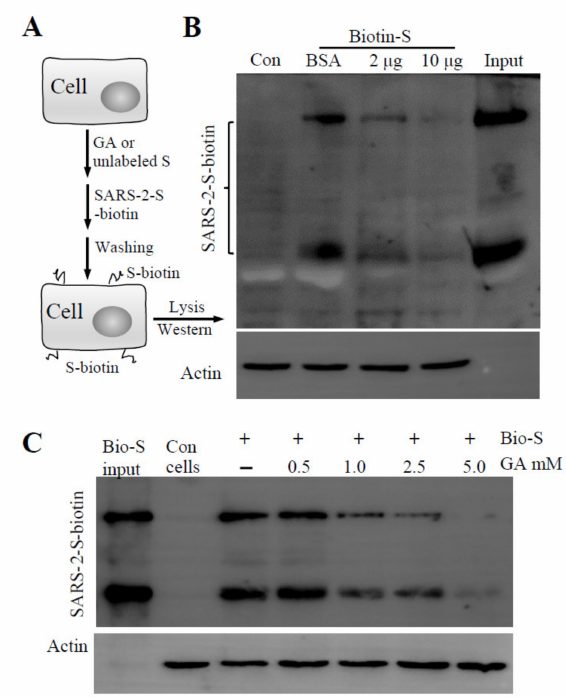
Figure 2. Effect of GA on recombinant S protein binding. ( A ) Schematic presentation of the experi- mental design. The cells were detached and incubated on ice for 60 min with GA or recombinant S protein (S unlabeled). Biotinylated S protein was then added for cell-attachment assay. After washing with ice-cold DMEM, cell-attached biotinylated S protein was detected by immunoblotting assay. ( B ) Biotinylated S protein binding to host cells in the presence of BSA or unlabeled S protein. Vero E6 cells resuspended in ice-cold DMEM containing 0.5% BSA were allowed to interact with Lenti-S in the presence or absence of unlabeled S protein (at 2 and 10 µ g/mL). ( C ) Effect of GA on S protein binding to Vero E6 cells. A biotinylated S protein was allowed to bind to detached Vero E6 cells in the absence or presence of GA. Cell-bound biotinylated S protein was determined by immunoblotting assay. Actin was used as a loading control. Con, Vero E6 cells only. Input, biotinylated S protein for total